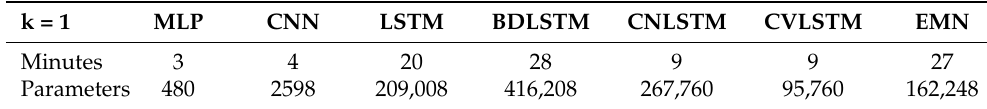
Table 2. The computational time required for the 100 training epochs. Number of trained parameters of the different DL models as obtained in the first fold of the 5-fold cross validation. k = 1 MLP CNN LSTM BDLSTM Parameters